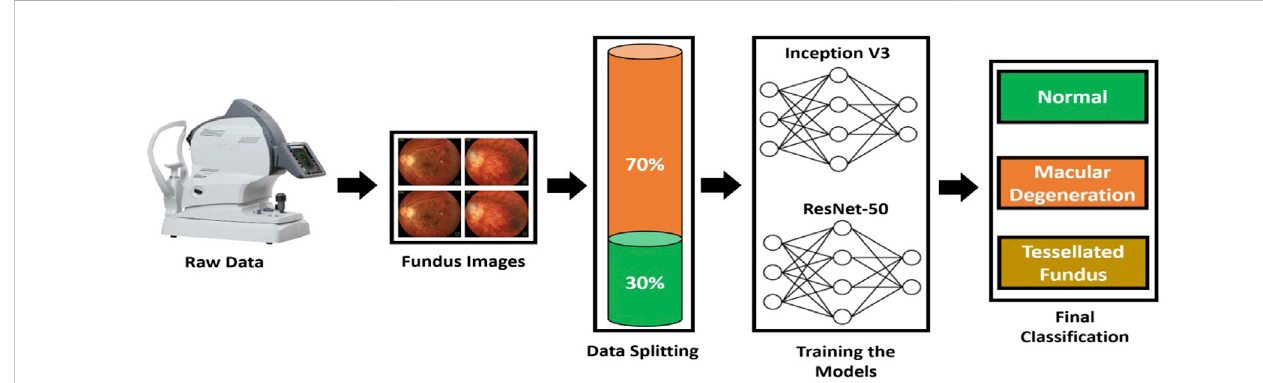
FIGURE 2 Proposed Framework to classify fundus images. A domain speci fi c image is collected from fundus camera; then, data is split to train and test set. Inception V3 and VGG-16 are trained according to the dataset to classify fundus